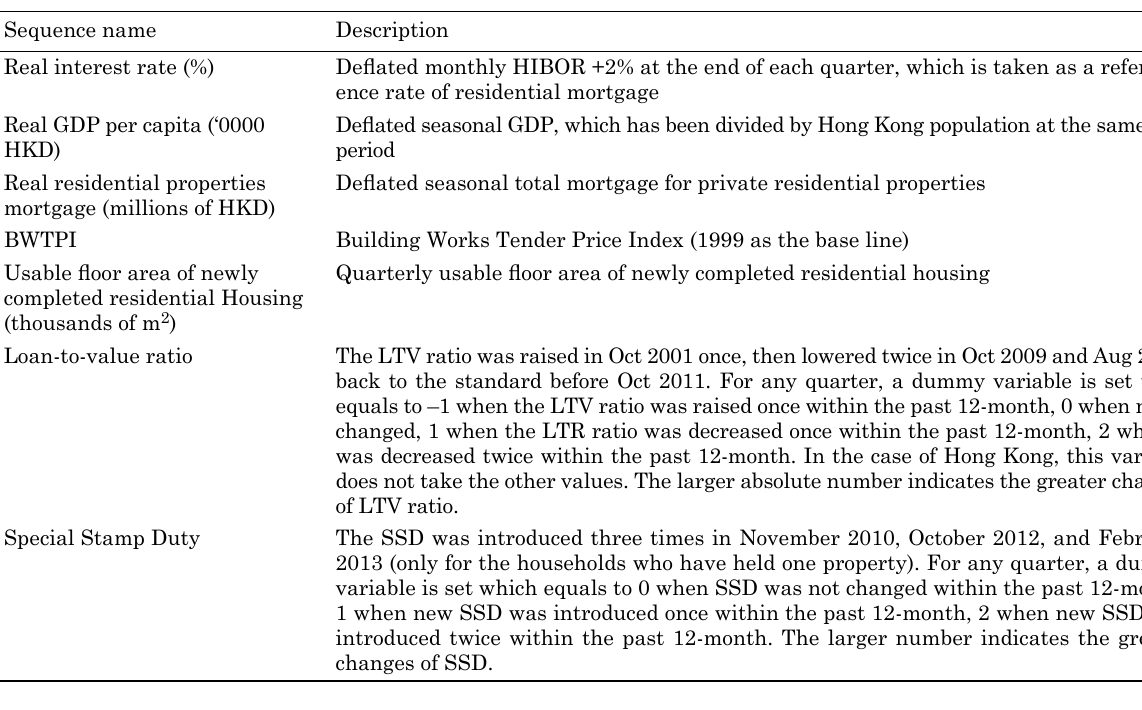
table 2. Description of time-series sequences in this study